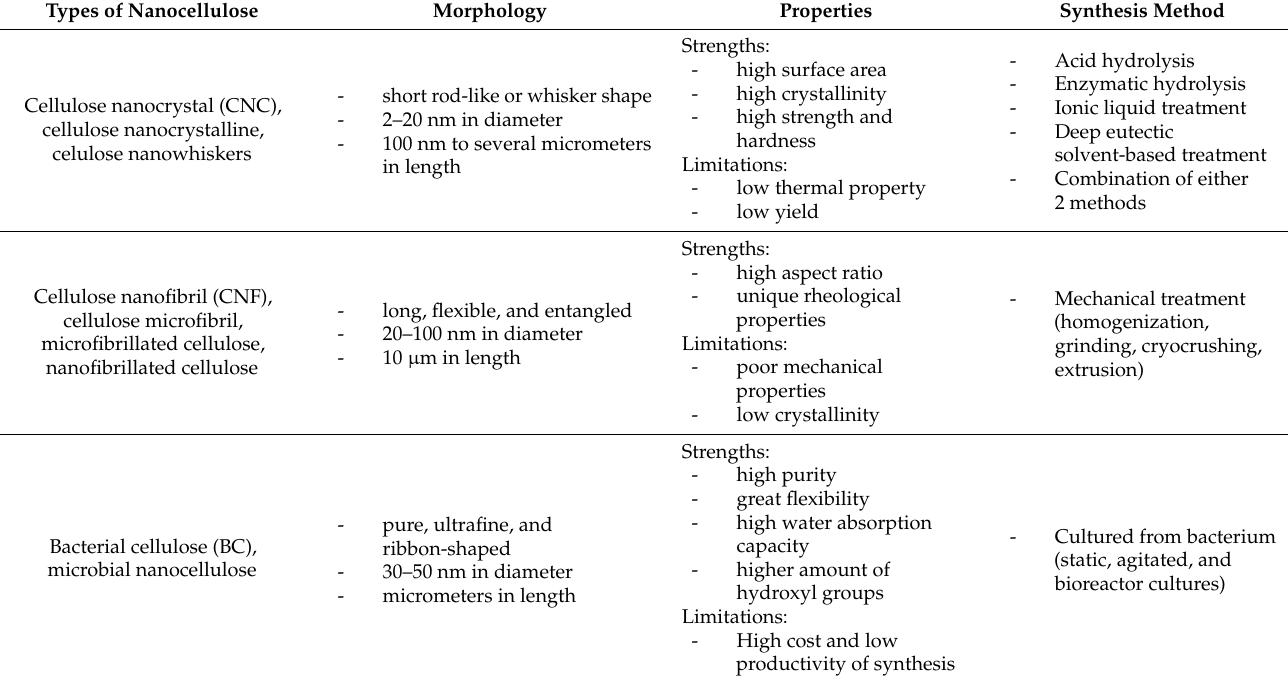
Table 2. Comparison of the different types of